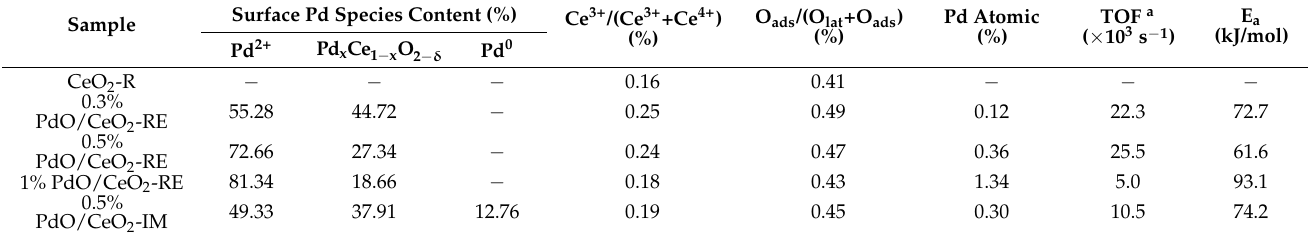
Table 2. Chemical and structural data of CeO 2 -R and Pd/CeO 2 catalysts.